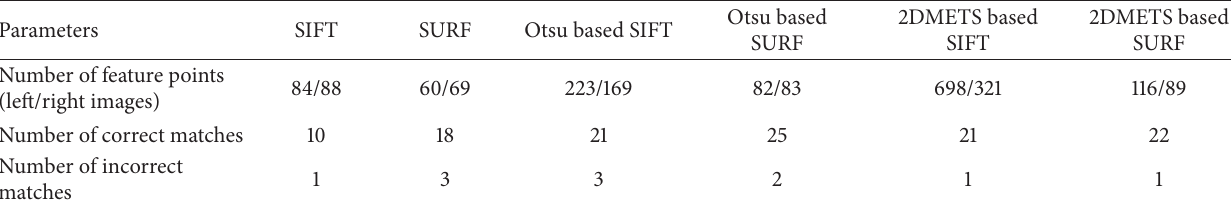
Figure 9: Target matching for images in group 4. Table 1: Matching performance for images in group